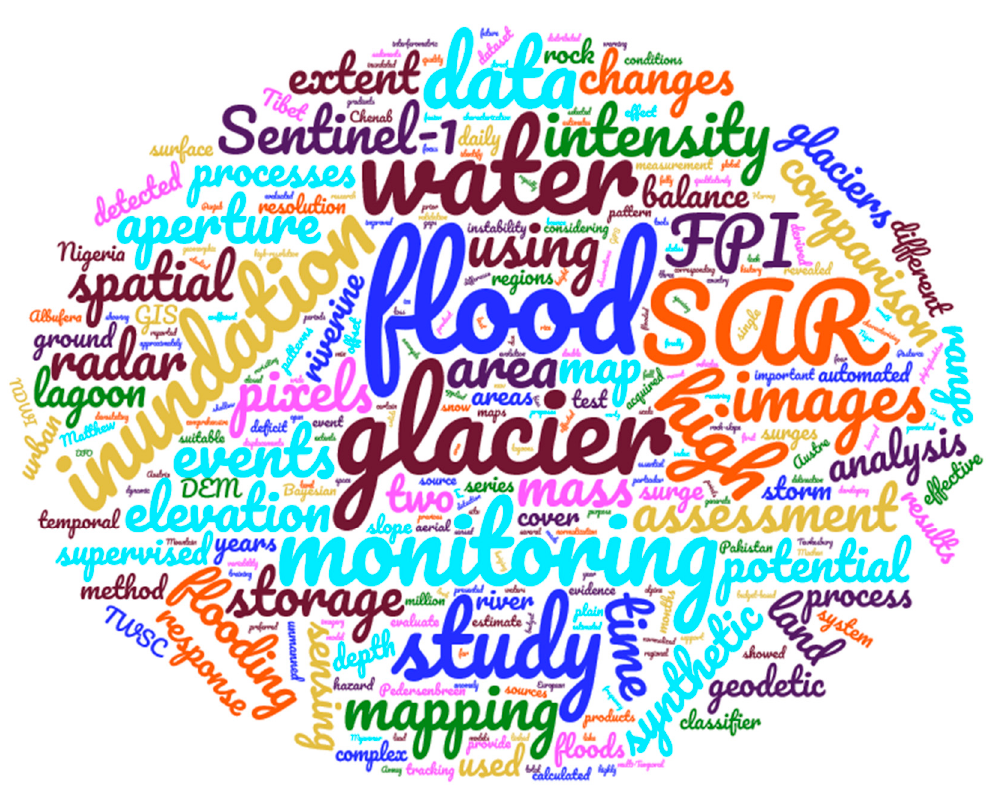
Figure 1. Thematic keywords of the 11 research papers composing the Special Issue “Imaging Floods and Glacier Geohazards with Remote Sensing” [6] of Remote Sensing (created with wordclouds.com).